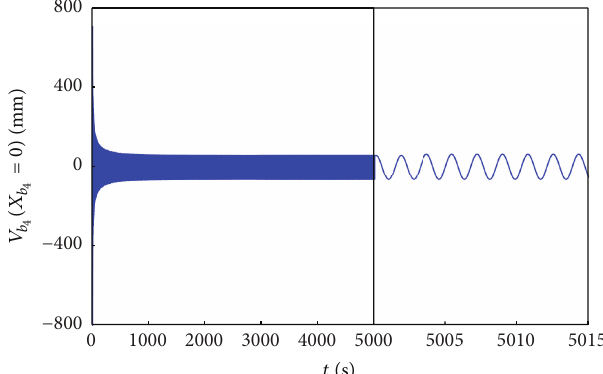
Figure 5: Time response of the midpoint of the deck beam, 𝑞 𝑟 (0) = 3𝛿 1𝑟 .